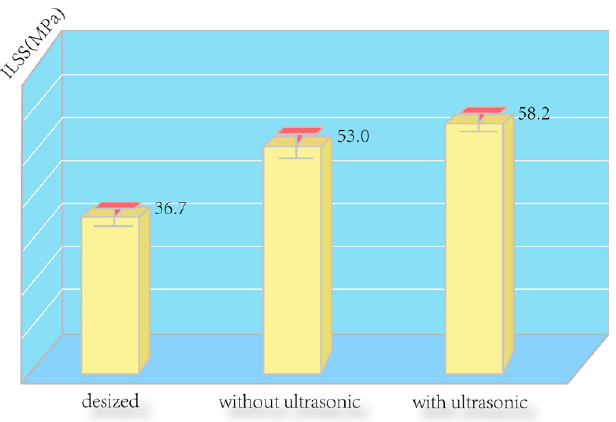
Figure 5. Interlaminar shear strength (ILSS) of the composites reinforced by the desized CF, CNTs deposited CF without ultrasonication, CNTs deposited CF with ultrasonication.